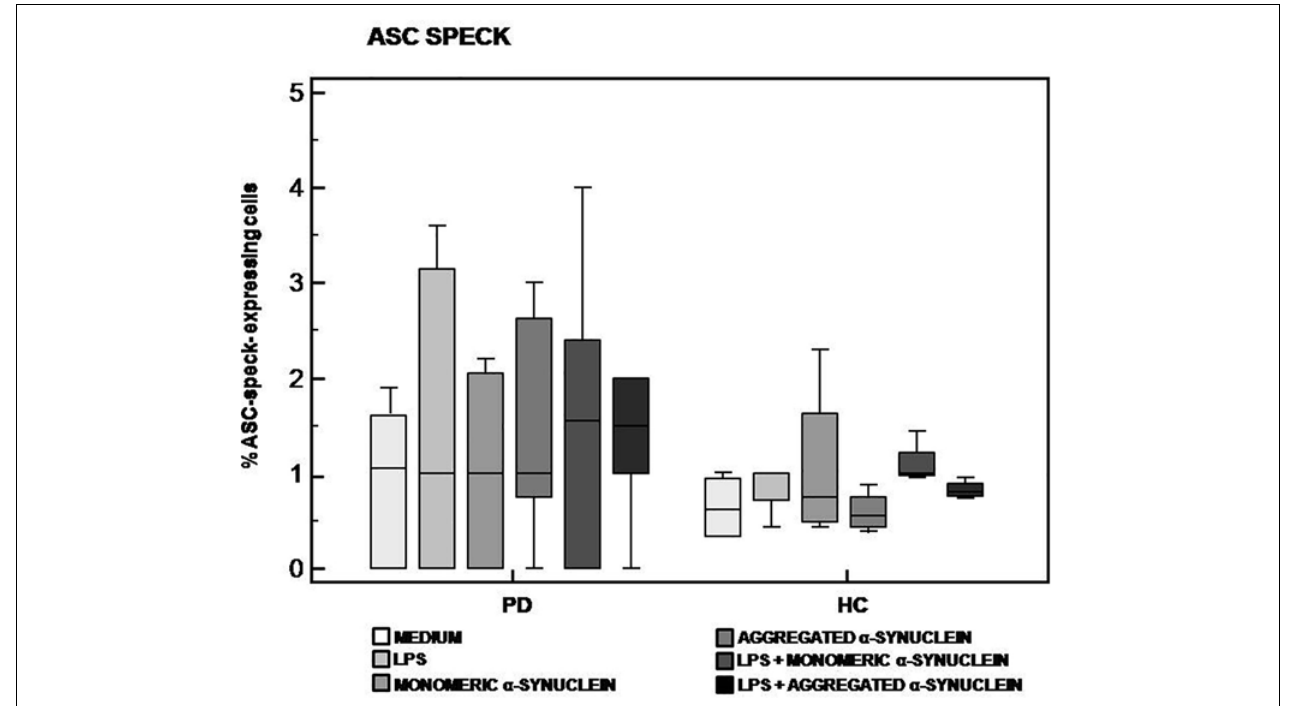
FIGURE 2 | ASC-speck formation in LPS-primed and monomeric or aggregated α -synuclein–stimulated cells of PD and HC subjects. ASC-speck formation in unstimulated, LPS-stimulated, monomeric α -synuclein–stimulated, aggregated α -synuclein–stimulated, LPS-primed and monomeric α -synuclein–stimulated, or LPS-primed and aggregated α -synuclein–stimulated cells of 15 Parkinson disease (PD) patients and 15 healthy controls (HC). Summary results of ASC-speck–positive cells are shown in the bar graphs. The boxes stretch from the 25th to the 75th percentile; the line across the boxes indicates the median values; the lines stretching from the boxes indicate extreme